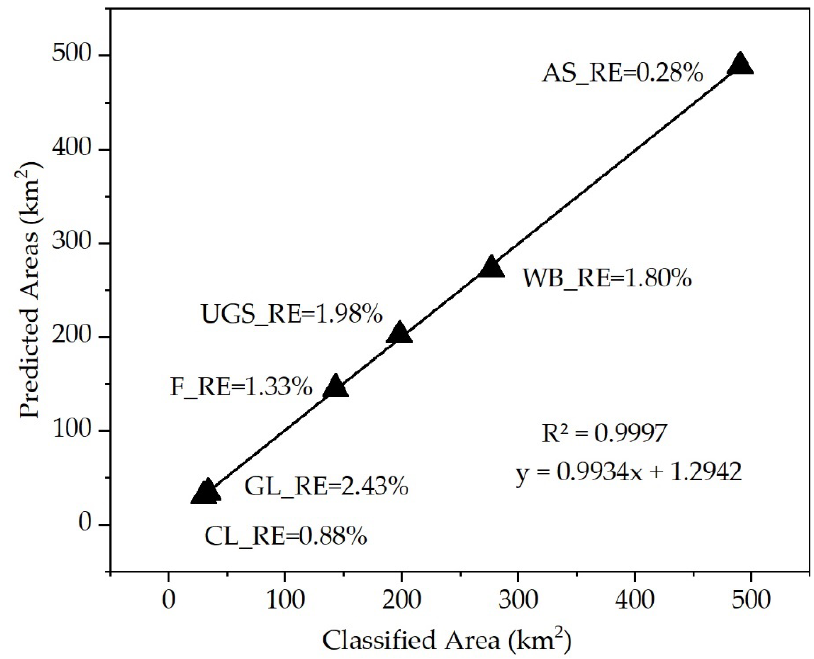
Figure 3. The error of Markov chain in 2010. (RE is the relative error between the simulated area of each land use and the actual classification area).